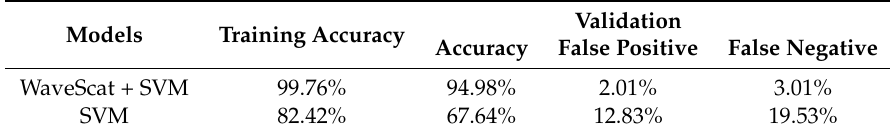
Table 4. Accuracy and confusion results of horizontal signals (noisy signals) with or without wavelet scattering networks in the machine learning